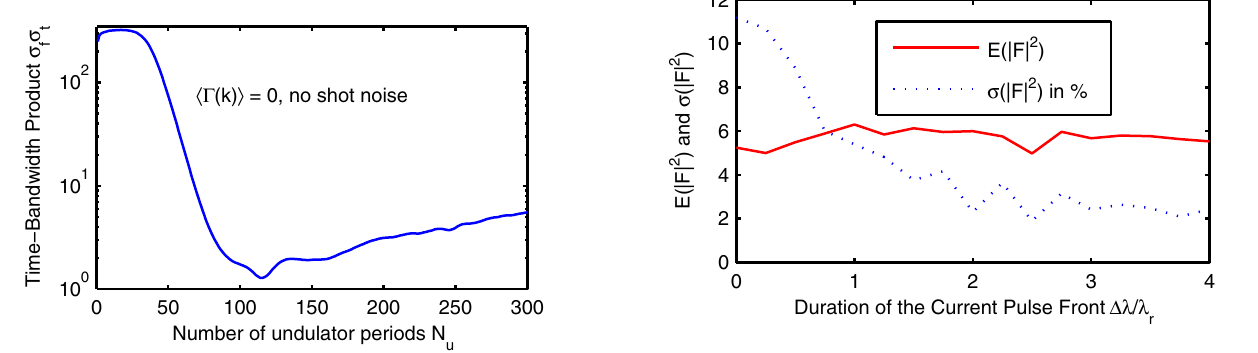
FIG. 13. Mean and normalized rms deviation of j F length of the current pulse front. The noise level is 3 orders of magnitude below the normal shot noise level, h (cid:3) ð k Þi ¼ 10 (cid:1) 3 .